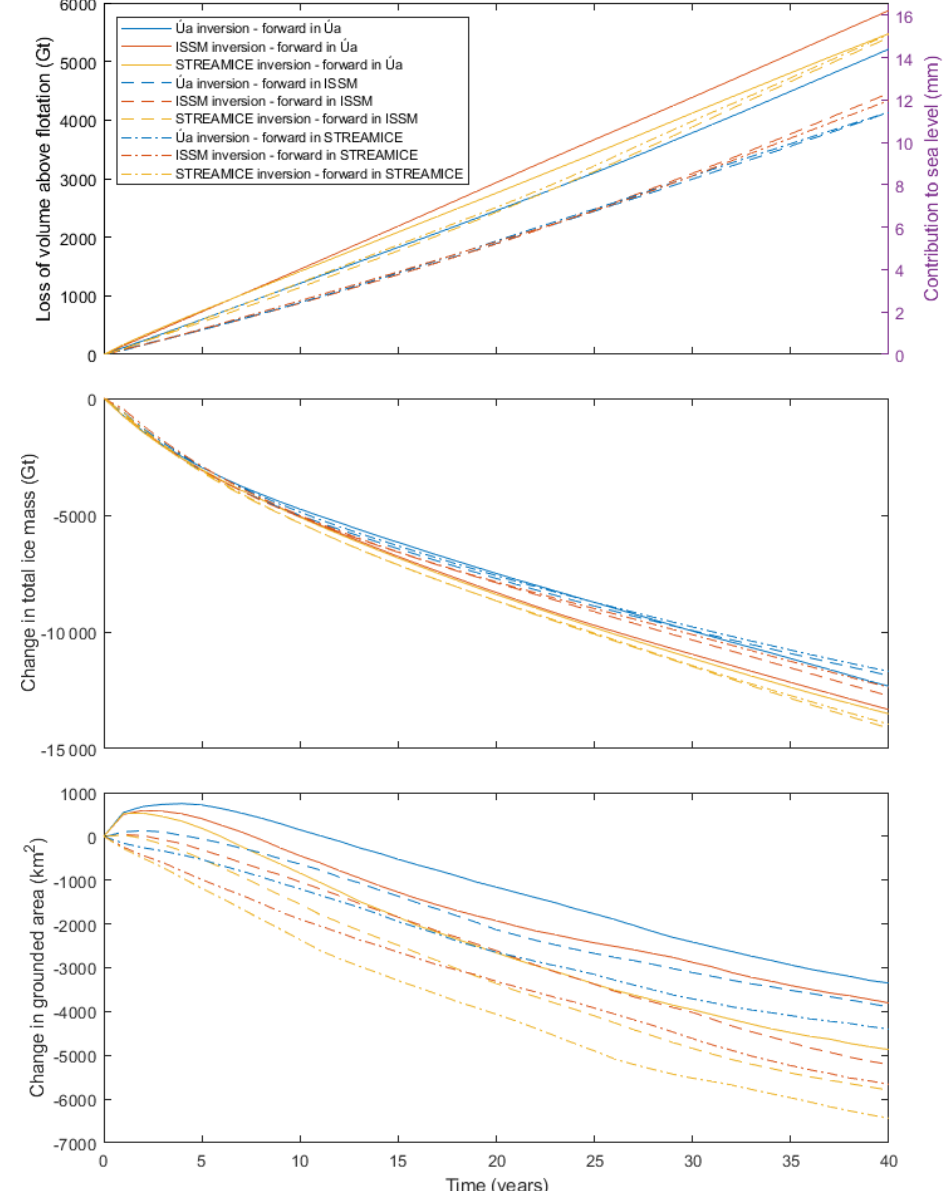
Figure 6. Changes in ice mass and grounded area over 40 years of simulation in Úa using the rate factor and basal sliding coefficient fields resulting from each of the three model